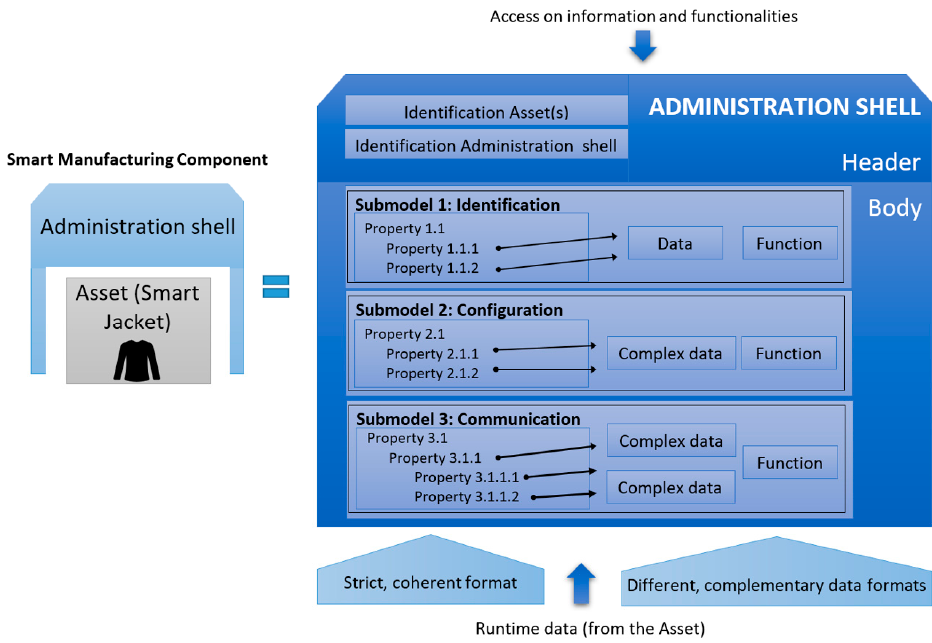
Figure 3. The Asset Administration Shell (inspired by [13,19]).